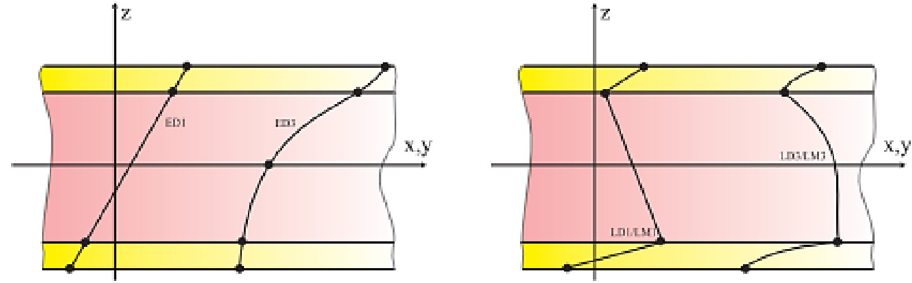
Fig 4. Example of the ESL (left) and LW (right) hypothesis